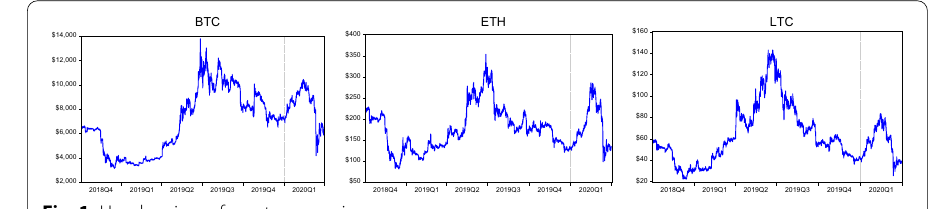
Fig. 1 Hourly prices of cryptocurrencies